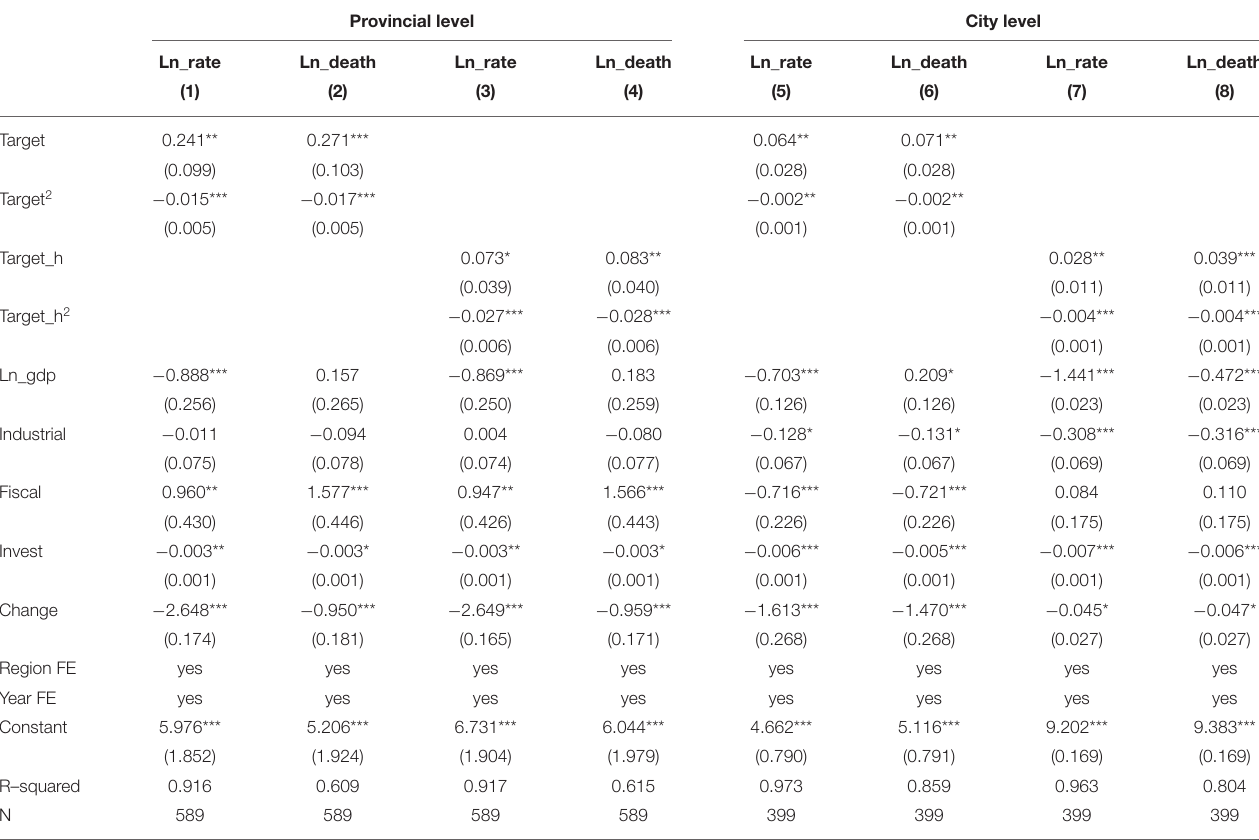
TABLE 2 | The result of panel regression.